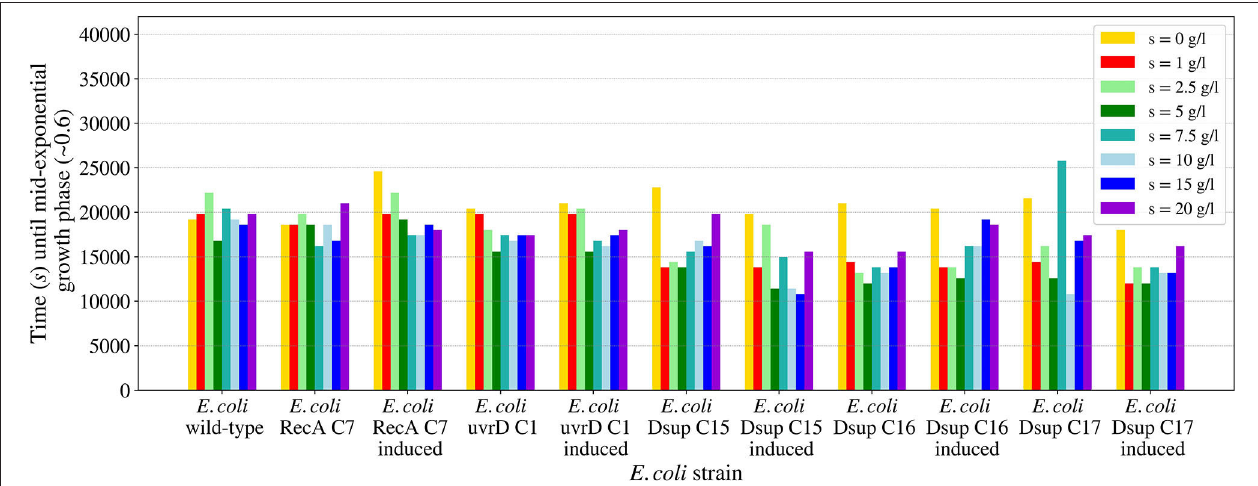
FIGURE 10 | Time needed for the E. coli wild-type and the selected colonies of the RecA, uvrD, and Dsup strains to reach mid-exponential growth phase (OD 600nm ∼ 0.6) when inoculated in LB media with different salinities. The effects of the gene products were tested with and without induction to detect any possible effects on cellular growth.